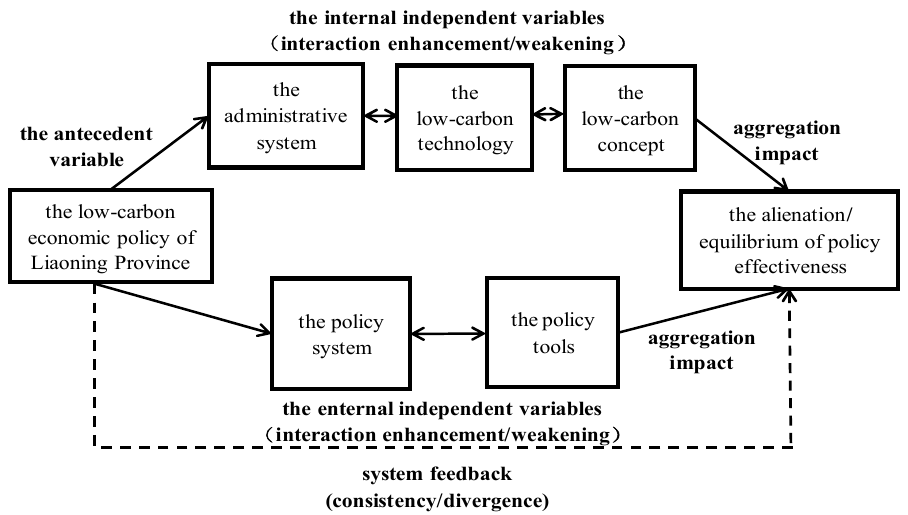
Figure 1. The multi-factor linkage mechanism of policy effectiveness of the low-carbon economy.